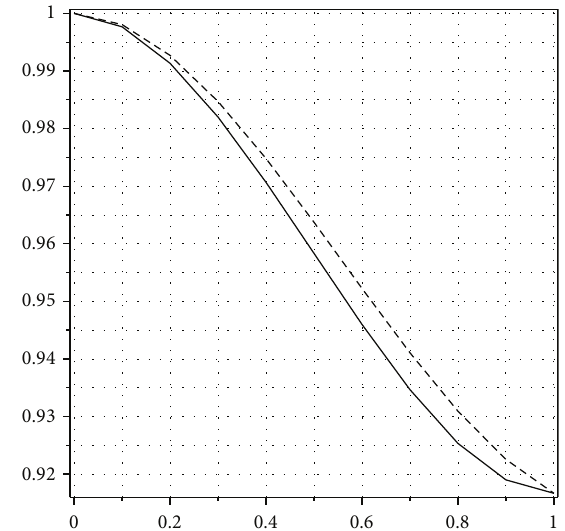
Figure 5: Comparison between exact and approximate solutions of Example 4 for 𝑘 = 1/2 . Solid line represents exact solution and dash line represents approximate solution.